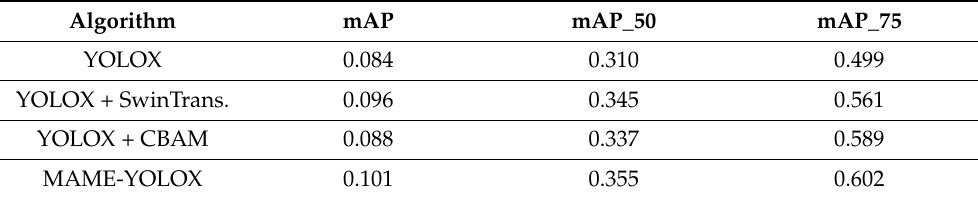
Table 10. The ablation experiments on the DIOR